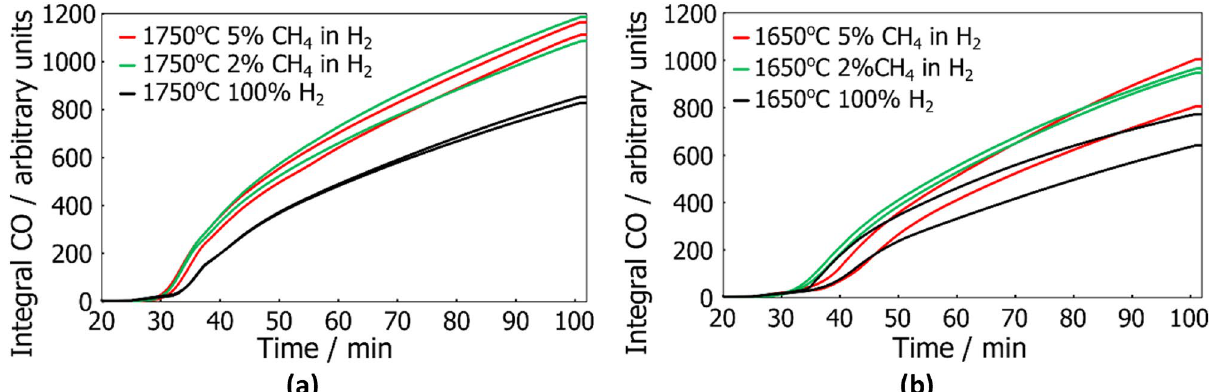
Figure 6. A comparison of the integral CO generated with different process gasses ( a ) at 1750 °C and ( b ) 1650 °C.